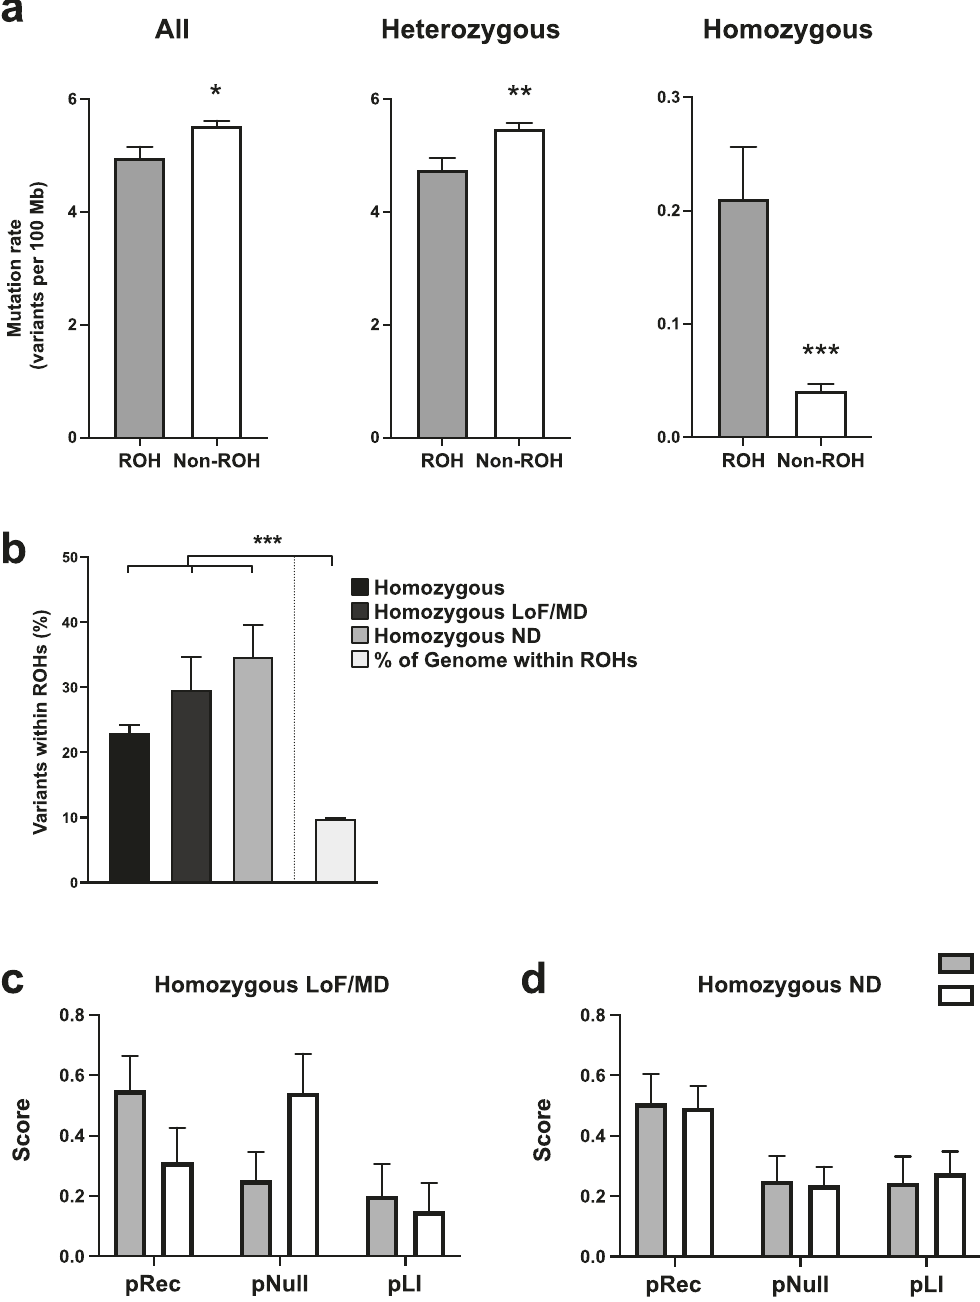
Fig. 2 Damaging mutations are enriched within ROHs. a Rate of all rare (* P = 0.0176), rare heterozygous (** P = 0.0025), and rare homozygous (*** P = 0.0004) LoF and MD variants per 10 8 base pairs within and outside ROHs ( N = 68 individuals). b The percentage of all, LoF/MD, and ND rare homozygous variants that fall within ROHs for each individual compared to the percentage of the genome that is within ROHs (*** P < 0.0001 for each comparison). The percentage of rare homozygous variants within ROHs that are LoF/MD compared to ND were not different ( N = 68 individuals; P = 0.4821). c Constraint scores for genes harboring rare inherited homozygous LoF/MD variants in affected individuals, represented by average pRec ( P = 0.1543), pNull ( P = 0.0818), and pLI ( P = 0.7232) scores from gnomAD ( N = 15 ROH genes, N = 14 non-ROH genes). d Constraint scores for genes harboring rare inherited homozygous ND variants in affected individuals, represented by average pRec ( P = 0.8951), pNull ( P = 0.8834), and pLI ( P = 0.7884) scores from gnomAD ( N = 24 ROH genes, N = 34 non-ROH genes). All values are mean ± SEM. Data were analyzed using unpaired t A majority of the enhancer variants (20/22) were also associated predicted human brain enhancers per genome (see Supplemen- with the activating chromatin markers H3K4me1 and H3K27ac tary Table 8). To identify regulatory variants that potentially (see Supplementary Table 10). We identi fi ed 49 inherited underlie neurodevelopmental disease, we focused on brain- homozygous noncoding variants that were shared between two speci fi c promoter and enhancer variants, of which there were 15 to three unrelated affected individuals. These shared variants and 22, respectively (see Fig. 1c and Supplementary Table 10).